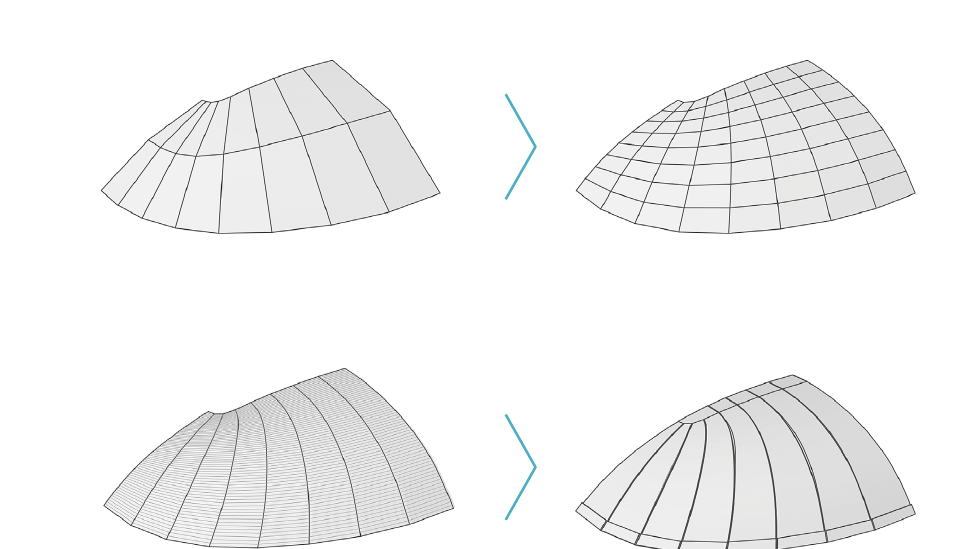
Figure 22: Discretization process from the coarse mesh to a developable strip model.